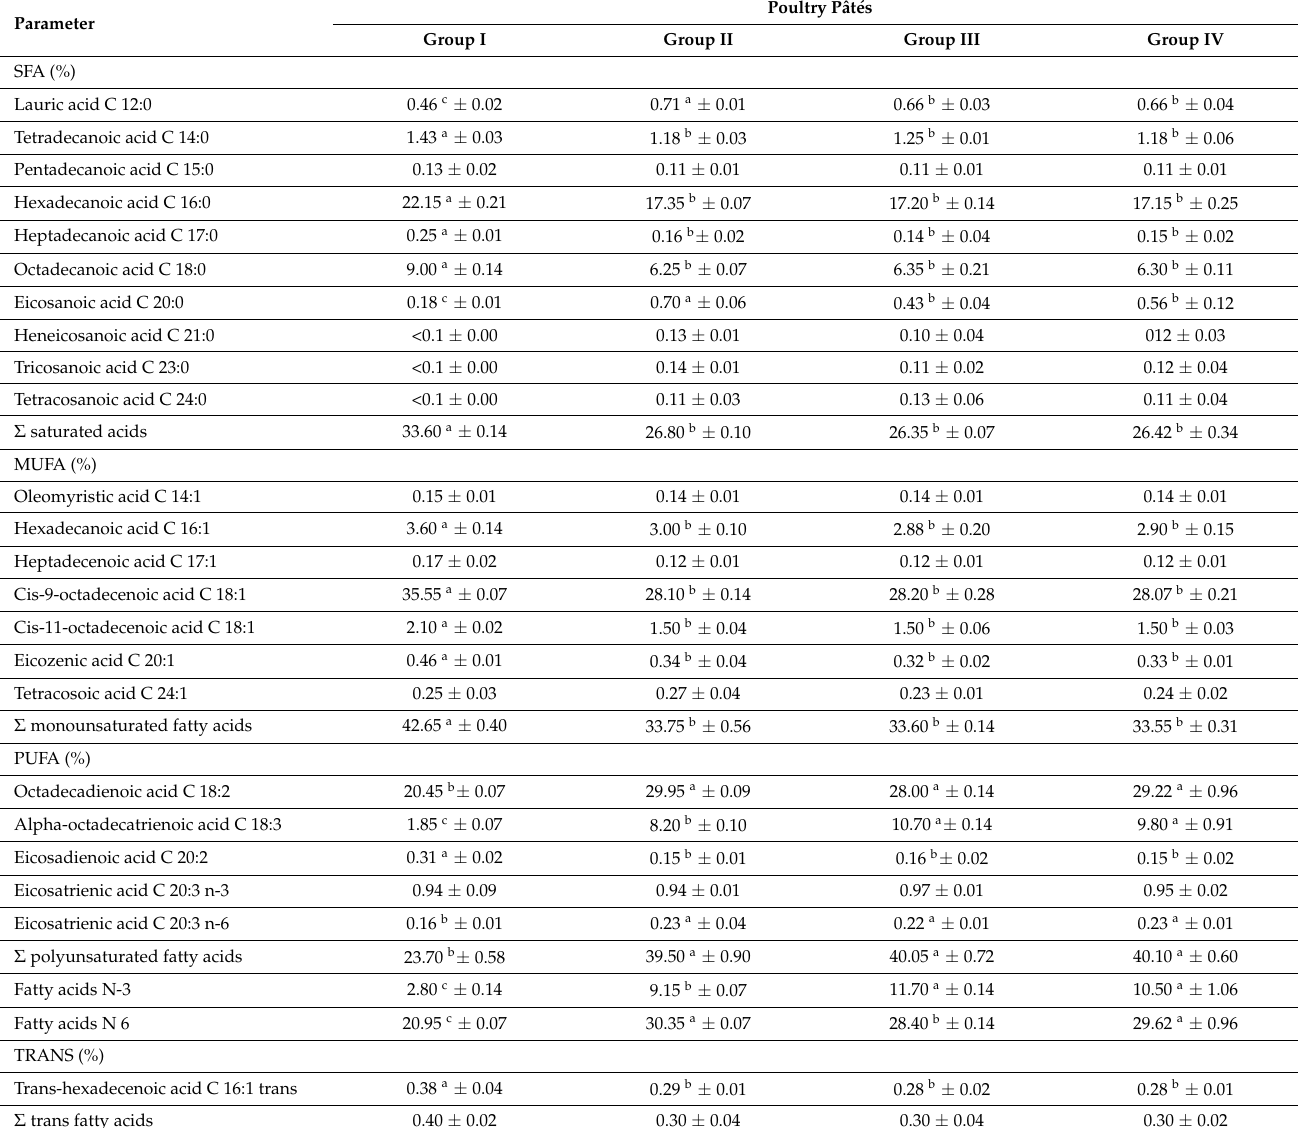
Table 5. Effect of the addition of hemp seeds, amaranth and golden flaxseed on the fatty acid profile ¯ of poultry p â t é s ( x ±